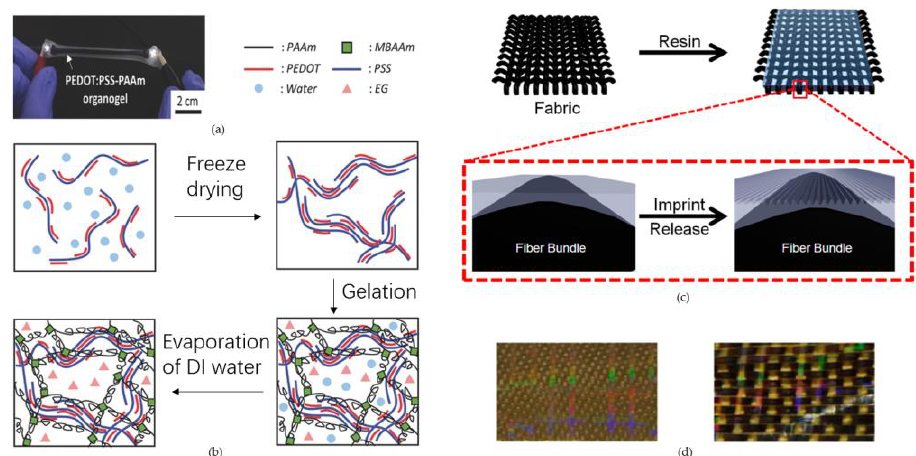
Figure 4. ( a ) Photo of PETDOT:PSS-PAAm organogel stretch up to 200% strain; ( b ) Synthesis pro- cedure of the electrically conductive PEDOT:PSS – PAAm organogels; ( c ) Schematic of the fabrication of a patterned fiber composite; ( d ) Macroscopic photographs of E-glass/x-PDMS and Kevlar-carbon fiber/x-PDMS. ( a , b ) Reproduced with permission. Ref. [38] Copyright 2016, Adv Mater. ( c , d ) Repro- duced with permission. Ref. [39] Copyright 2012, ACS Appl Mater Interfaces.